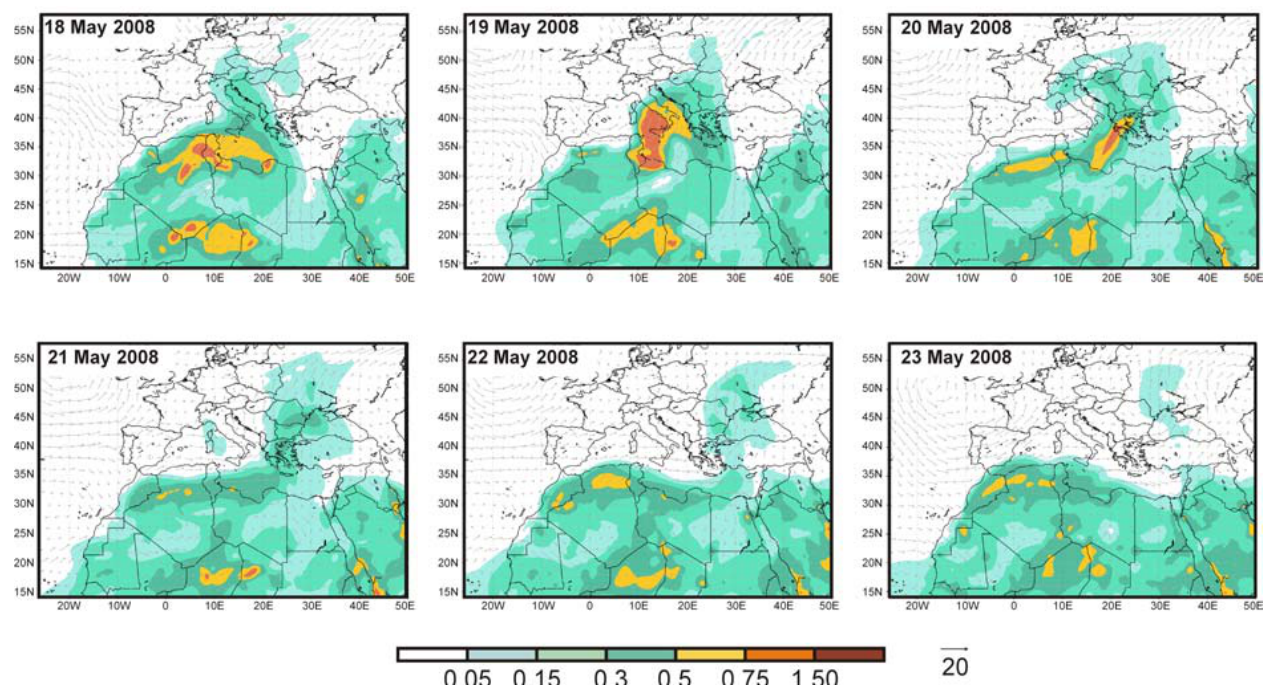
Fig. 1. Dust loading and 3000m wind fields over Europe for the period 18–23 May 2008, as estimated by the BSC-DREAM model